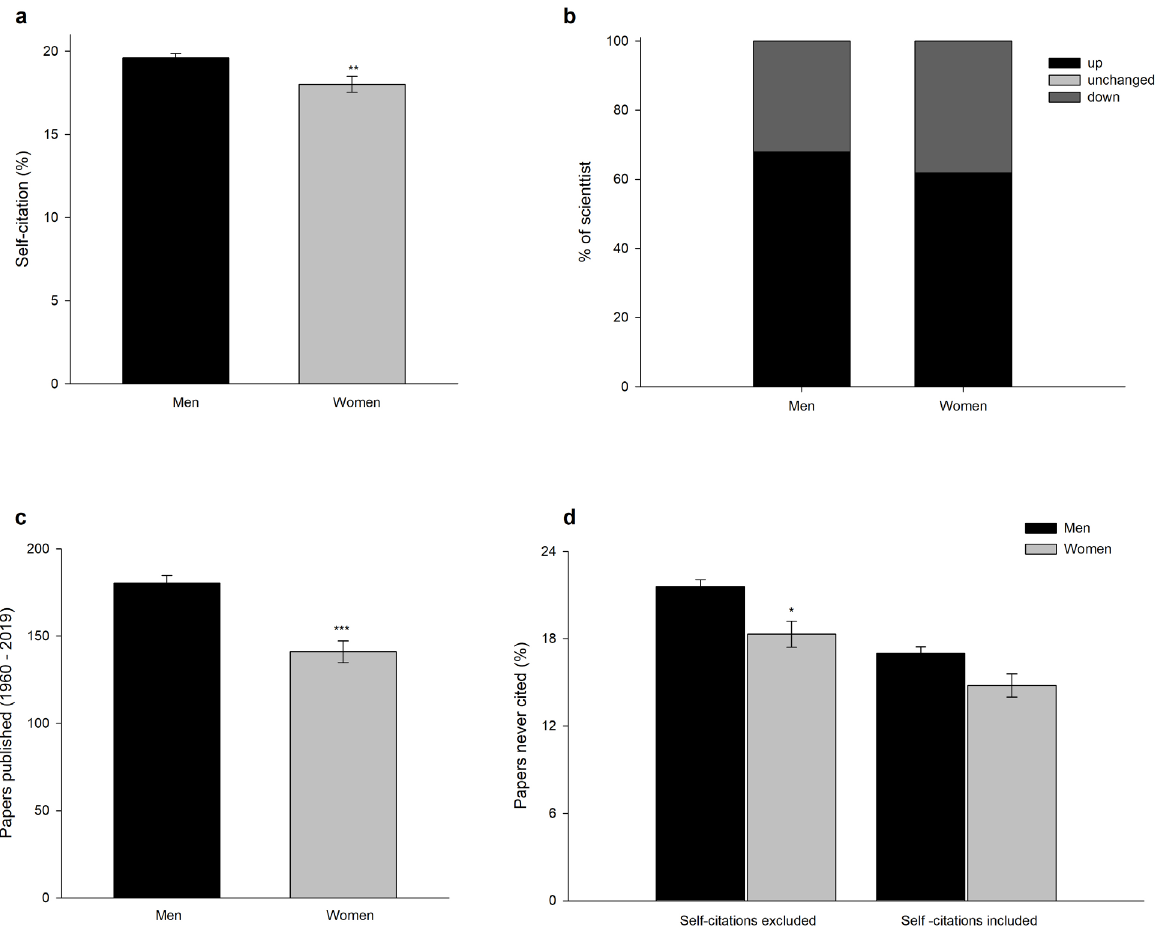
Figure 2. Number of published papers and self-citation impact by gender. a. Percentage of self-citations by Brazilian scientists by gender. b. Rank position changes after the inclusion of self-citations. (c) Number of papers published between 1960 and 2019. (d) Number of papers published between 1960 and 2019 that were never cited, including and excluding self-citations. Data are shown as percentage (b) or mean + standard error (a, c, d). Statistical differences between means were analyzed using Student’s t-tests (* p < 0.05, ** p < 0.01, *** p <